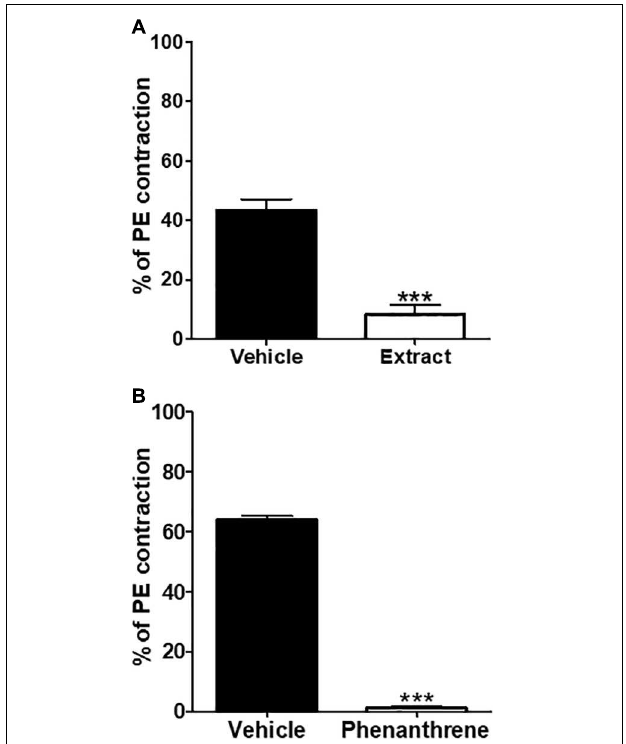
Ca 2 + release. The endothelium-denuded mesenteric rings were pre-incubated with 10 − 7 M verapamil for 30 min before adding 10 − 5 M PE in order to induce contraction in Ca 2 + free solution containing the vehicle, the EM extract (125 µ g/ml) (A) or the phenanthrene (35 µ M) (B) . Values are means ± SEM of n individual arteries. ∗∗∗ p < 0.001 vs. vehicle, ( n =